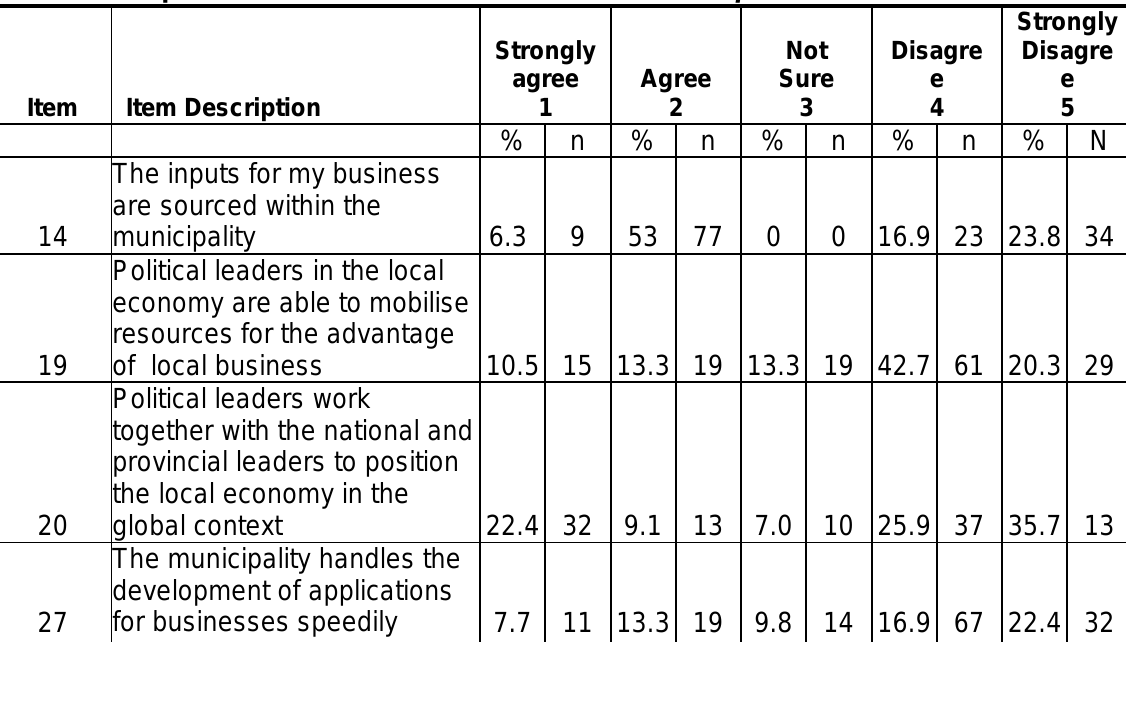
Table 5: Responses to the Markets and Business Development factor